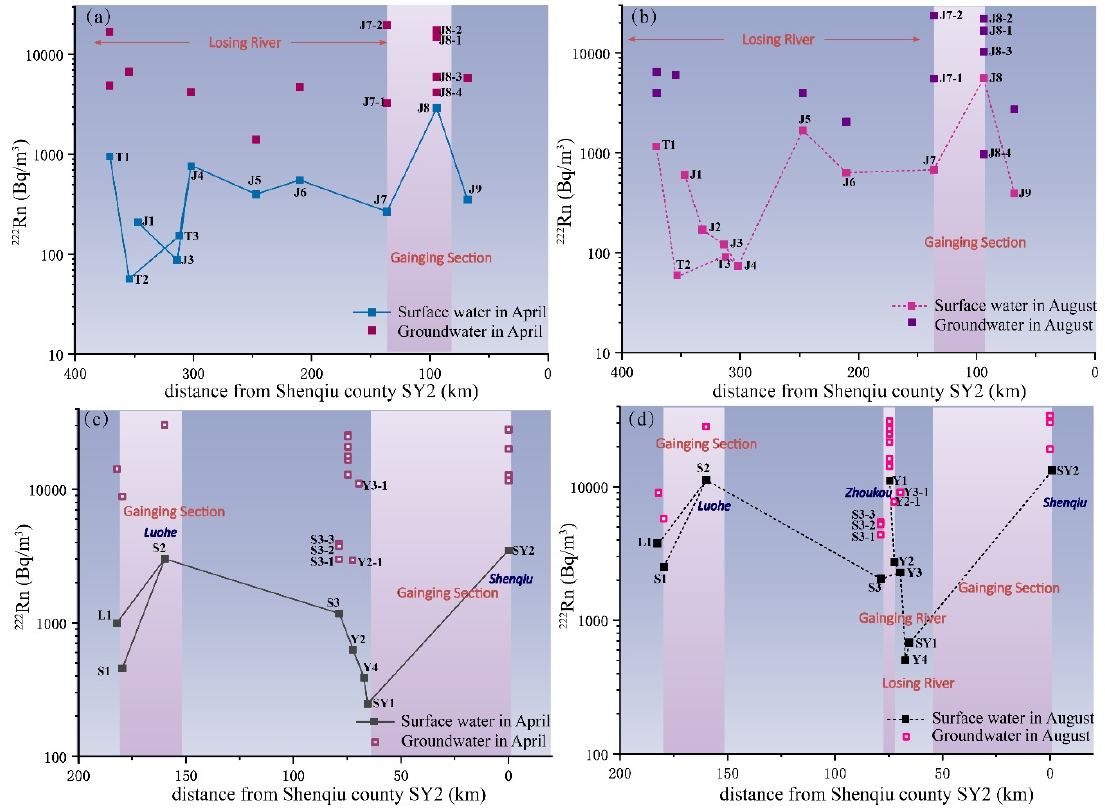
Figure 11. The distance from SY2 (Shenqiu county) profiles for 222 Rn activities in the ( a ) Jialu River in the dry season, ( b ) Jialu River in the wet season, ( c ) Shaying River in the dry season, and ( d ) Shaying River in the wet season.